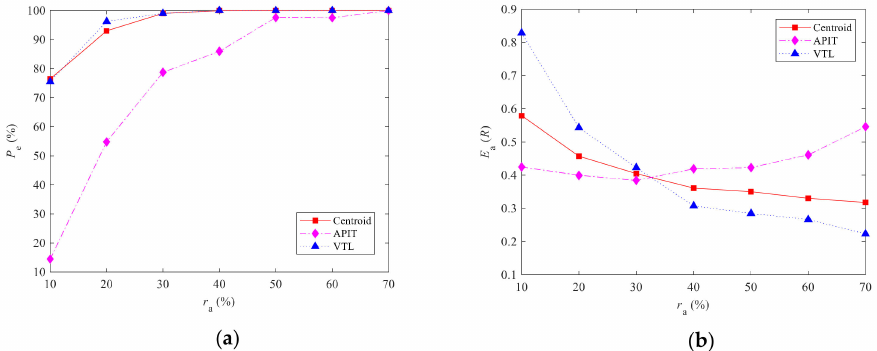
Figure 15. Effect of ratio of anchor nodes r a on three schemes (C-shaped topology in Figure 14, N t = 140, R a = R = 20 m, E GPS = 0, K = 6). ( a ) Estimation percentage P e . ( b ) Average estimation error E a